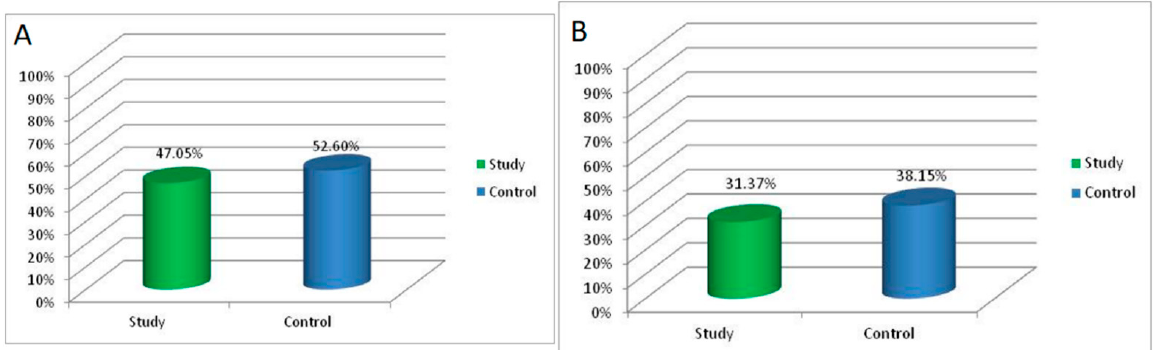
Figure 2. ( A ) Proportion of patients with an improvement of at least 2 lines on the LogMAR chart ( B ). Proportion of patients with an improvement of at least 3 lines on the LogMAR